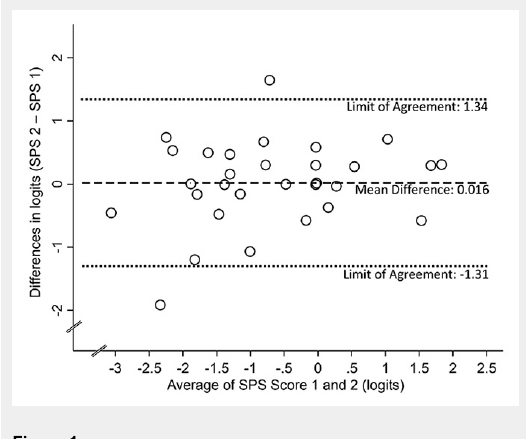
Bland–Altman plot for the Situational Pain Scale (SPS) total score (in logits), with limits of agreements interval (pointed line) of the mean difference (dashed line) between the two assessment